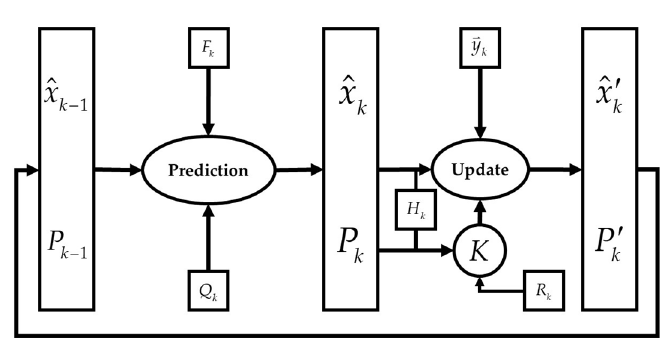
Figure 5. Flowchart of the Extended Kalman Filter.